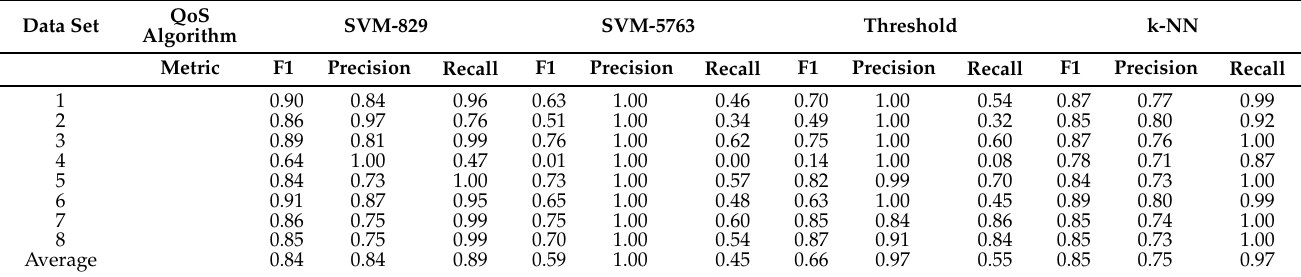
Table 4. Binary classification